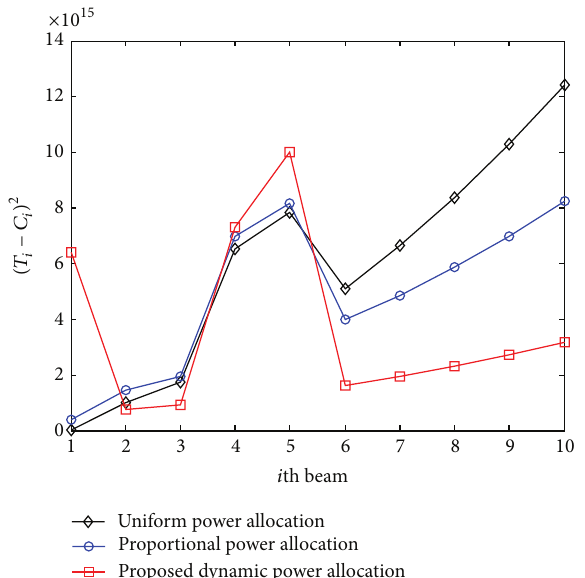
Figure 7: Distribution of squared difference between the traffic demand and the capacities allocated to each beam, for the three algorithms in Scenario